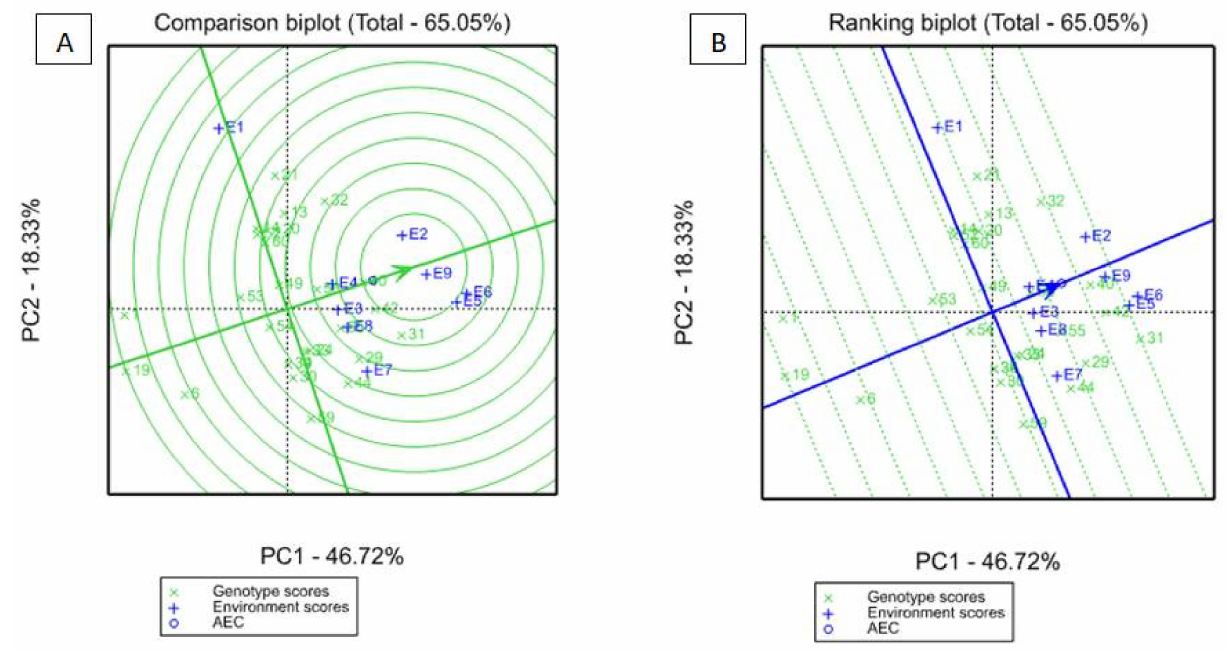
Figure 1. GGE biplots showing adaptation and stability of genotypes across nine environments. ( A ) A comparison GGE biplot (genotype scaling) showing adaptation and stability of genotypes across nine environments, ( B ) A ranking GGE biplot showing the mean grain yield performance of 26 maize hybrids/OPV produced across nine environments in Zimbabwe. Genotypes are iden- tified by a code prefixed by an ‘x’. Environments are identified by a number prefixed by a ‘+E’: +E1 = Harare-DR&SS-2019; +E2 = Harare-CIMMYT-2019; +E3 = Gwebi-2019; +E4 = Chisumbanje- 2019; +E5 = Panmure-2019; +E6 = Rattray-Arnold-2020; +E7 = Gwebi-2020; +E8 = Chiredzi-2020; +E9 =